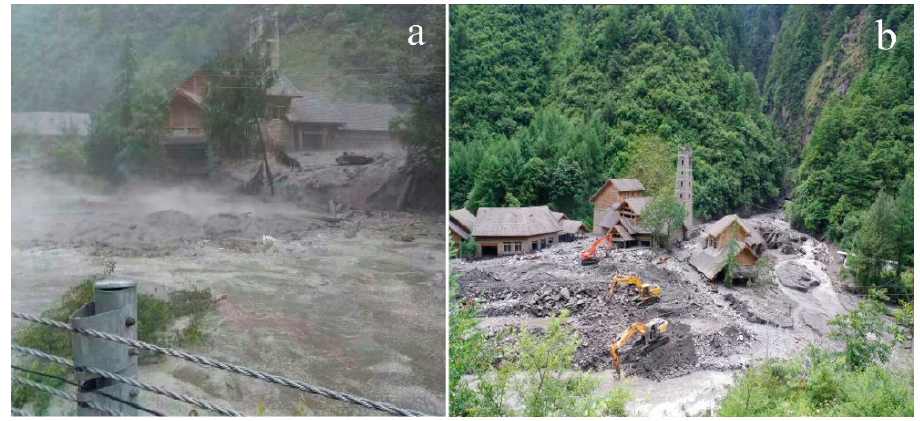
Figure 3. Photo of the scene of the debris flow on 26 July 2016: ( a ) the outbreak of the debris flow before blocking of the main river; ( b ) emergency drainage of the debris flow which has dammed the river.